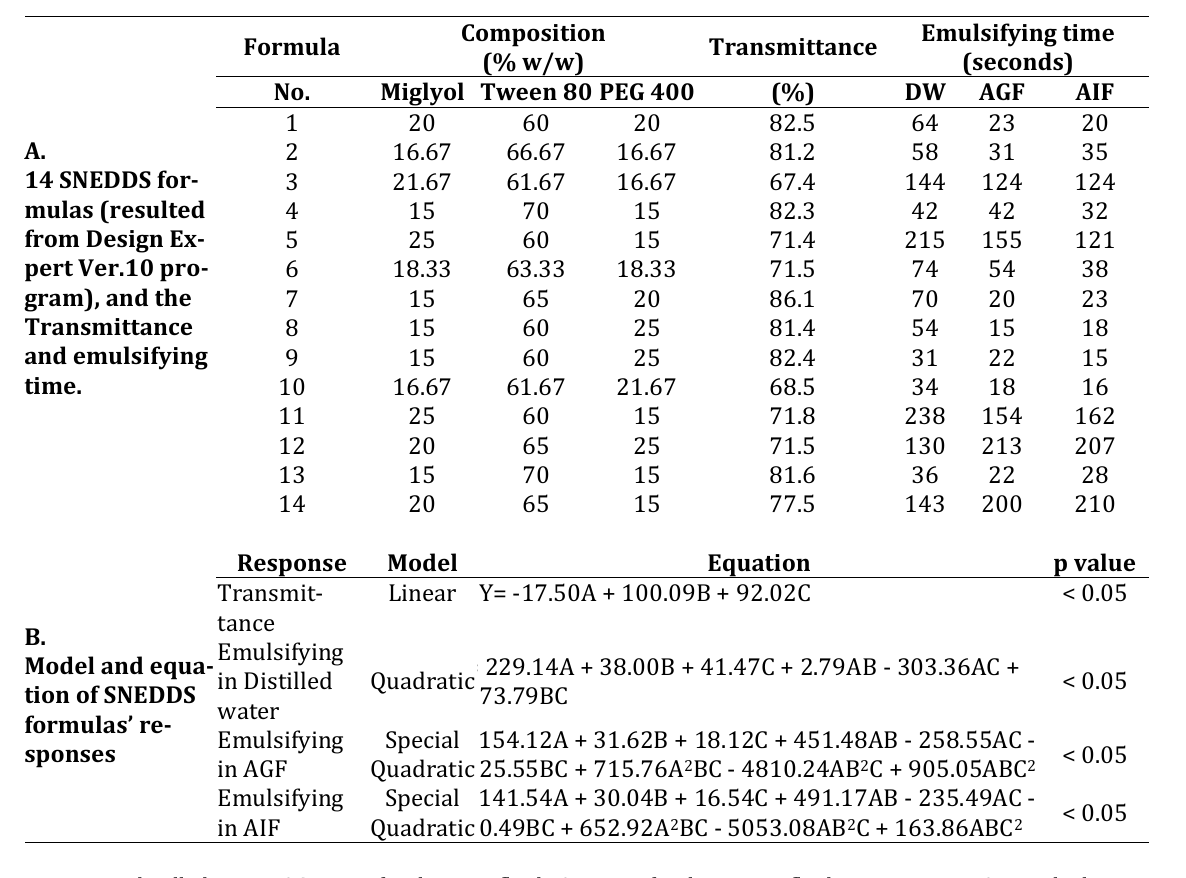
Table II. SNEDDS formulas and the response models and equations